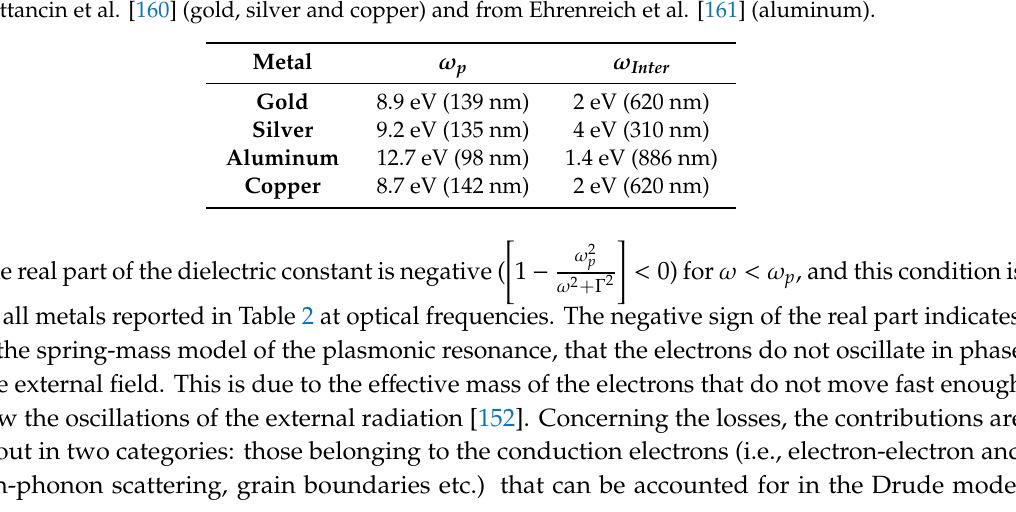
Figure 8. Scattering, absorption, extinction, and local field e ffi ciencies ( Q SCA ( ω ) , Q ABS ( ω ) , Q E ( ω ) , Q NF ( ω ), respectively) for a silver nanoparticle with radius 𝑎 = 22 nm immersed in water. These quantities are proportional to the corresponding cross-sections (i.e., Q SCA ( ω ) = for the others). Reproduced with permission from Messinger et al. [158]. Copyright (1981), American Physical Society.